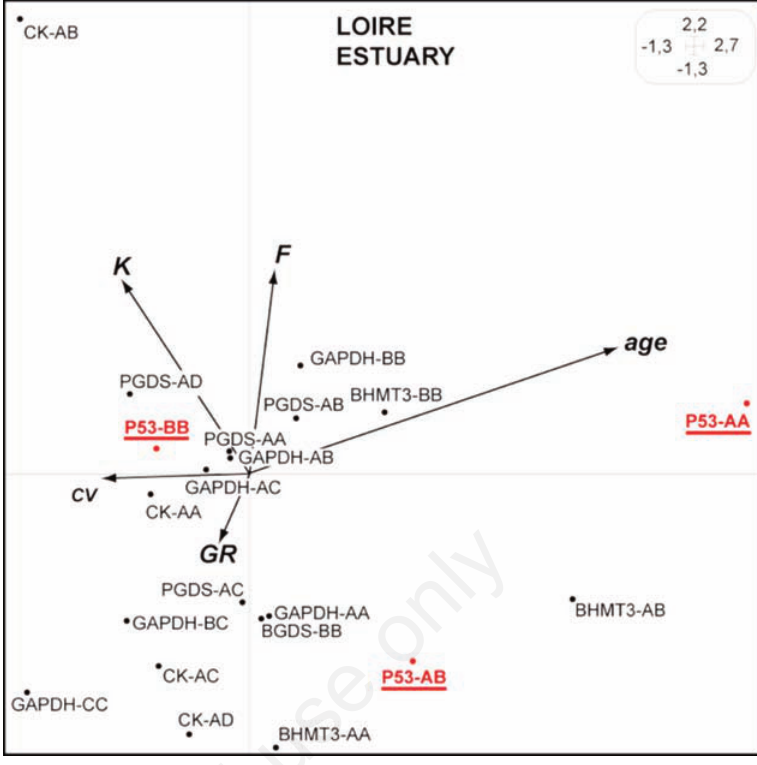
Figure 2. Synthetic Hill and Smith analysis for European flounders from the Loire estuary. The main 2 first axes explain 48% of the total variance. See Figure 1 caption for details.).